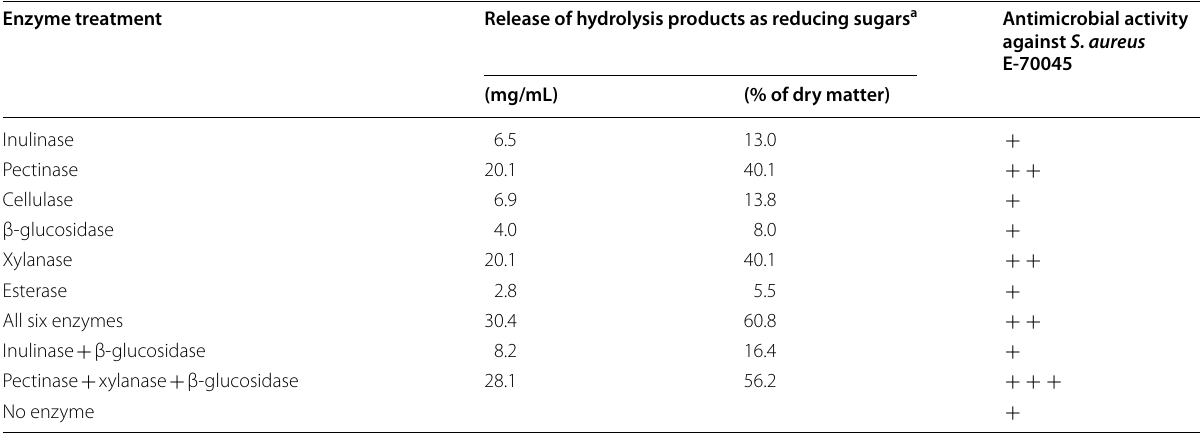
Table 1 Chicory sample #3 treated with individual enzymes or mixtures (5 mg/g protein) were assessed for total reducing sugars (DNS) and antimicrobial activity against S.